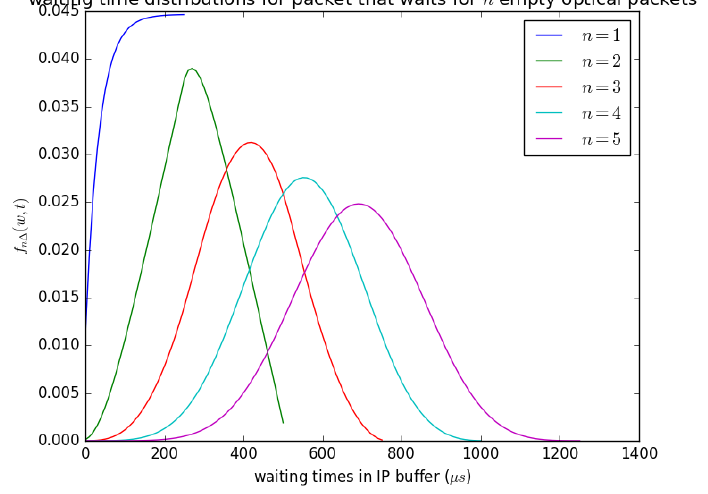
Figure 19. f Wn ( w ) as defined in Equation (25); the influence of the number of empty optical packets n needed to complete the transfer on the waiting time distribution, p =